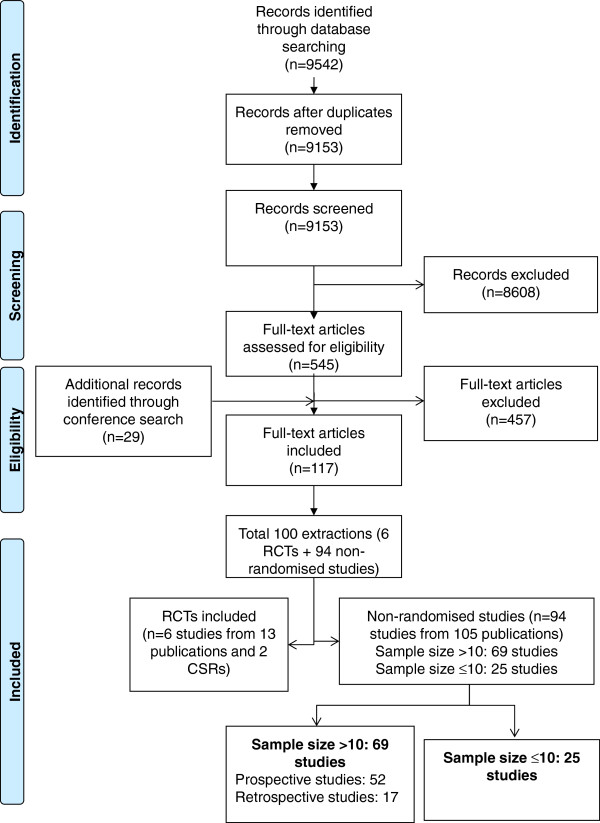
Flow of studies through the systematic review process. The figure describes the flow of studies through the review, according to PRISMA guidelines. The search of the literature databases yielded 9542 separate references. Following the screening of abstracts and full-text publications against the inclusion/exclusion criteria a total of six RCTs (reported in 13 publications) and 94 non-randomised studies (reported in 105 publications) met the inclusion criteria for the review.